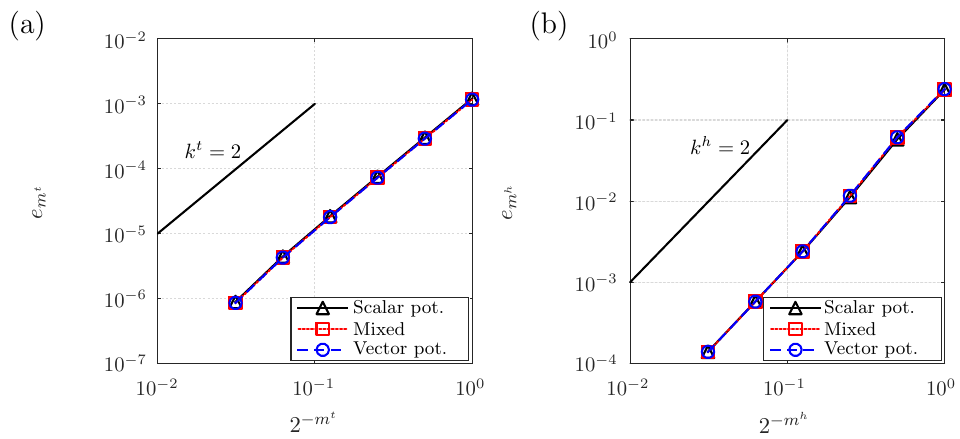
Figure 4. Convergence results for example 1: ( a ) temporal convergence; and ( b ) spatial